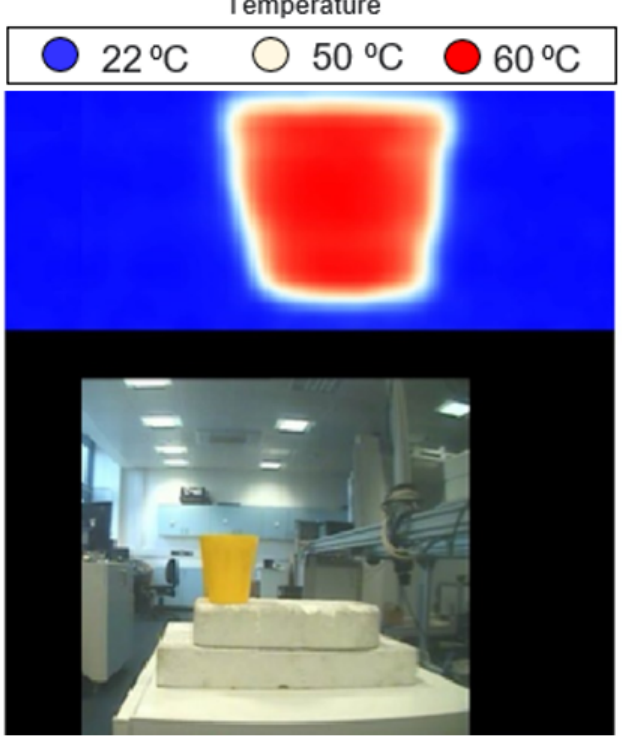
Figure 6. MMW image for a plastic cup having hot water